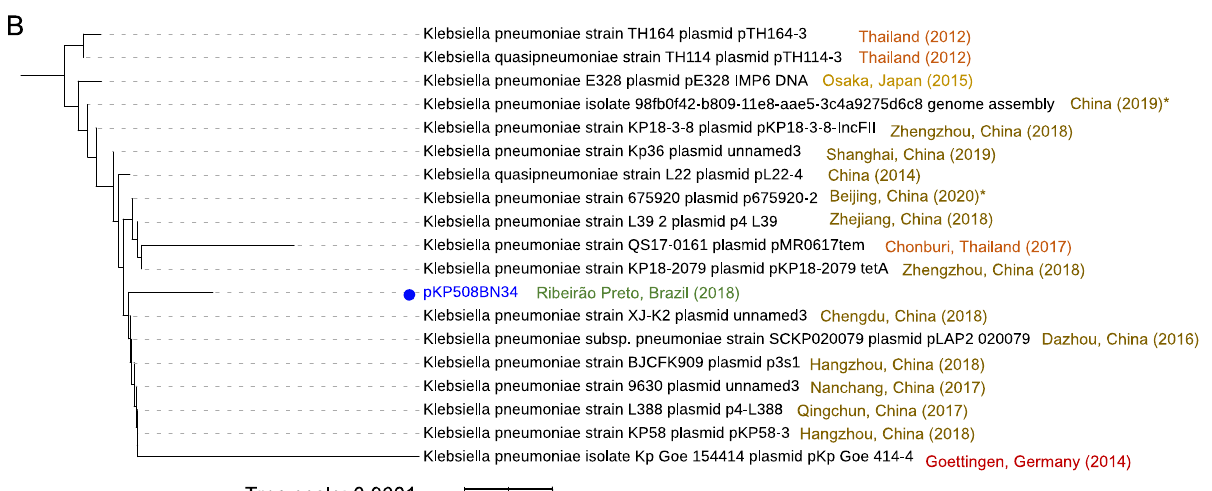
Figure 7. Distance relationship analysis for two plasmids from K. pneumoniae . ( A ) Distance relationship of the seven closest plasmids’ nucleotide sequences to pKP98M3N42, showing an E -value of less than 0.0 and a minimal sequence cover of 70% in BLAST analysis. The tree was produced using pairwise alignments by means of the fast-minimum evolution method. The year denotes the collection data, and the asterisk indicates the data reported in the public database. ( B ) Distance relationship of the 18 closest plasmids’ nucleotide sequences to pKP508BN34, showing an E -value of less than 0.0 and a minimal sequence cover of 50% in BLAST analysis. The tree was produced using pairwise alignments by means of the fast-minimum evolution method. The year indicates the collection data and the asterisk indicates the data reported in the public database, provided when the collection data were not available. iTOL (https://itol.embl.de accessed on 1 December 2020) was used for tree visualization.